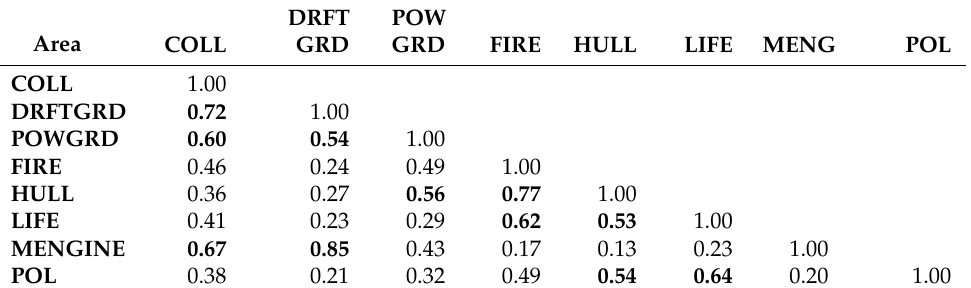
Table A3. Correlation of percentile ranks of vessel inspection priority risk